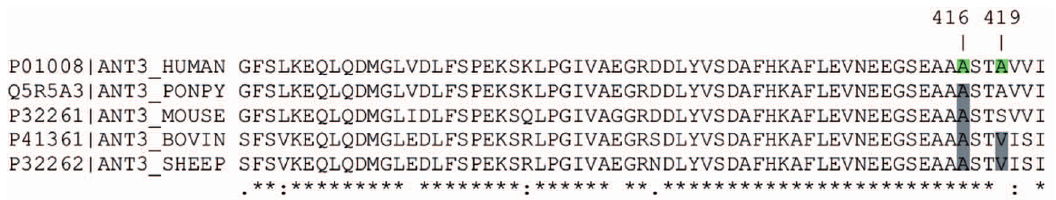
Figure 1 Examples of two disease-associated mutations (DAMs) reproduced from our structural analysis (10). The Figure shows the alignment of the human antithrombin III (ANT3) protein sequence with non-human functionally equivalent homologous proteins. Highlighted are columns 416 and 419 which represent an uncompensated pathogenic deviation (PD) and a compensated pathogenic deviation (CPD), respectively.